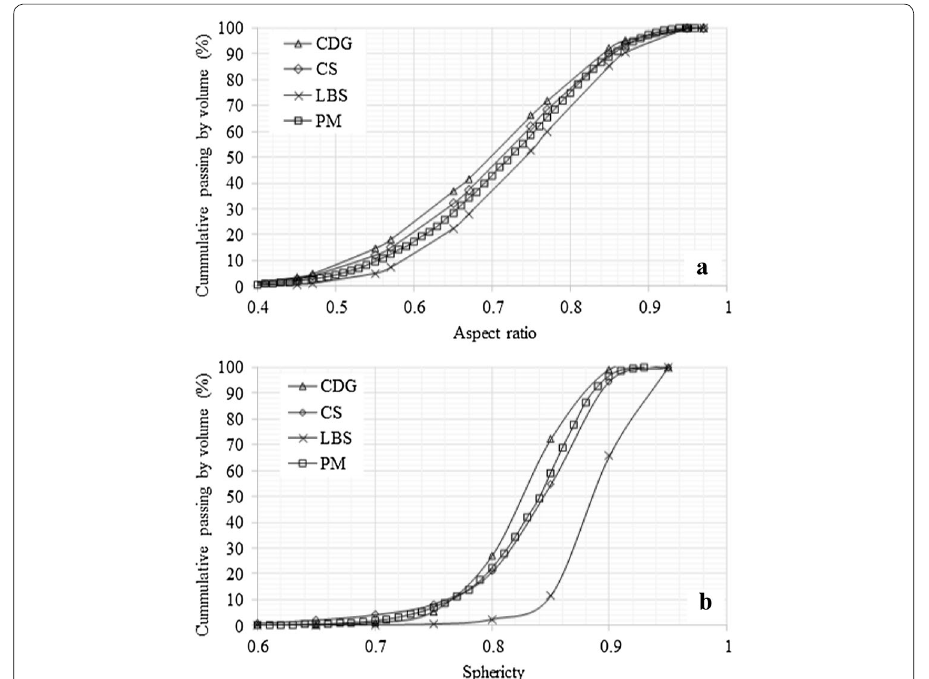
Fig. 4 Shape distribution: a aspect ratio; b sphericity